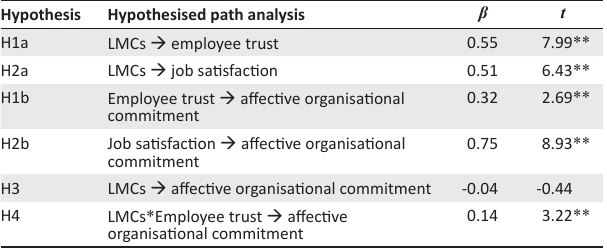
TABLE 3: Structural coefficients.